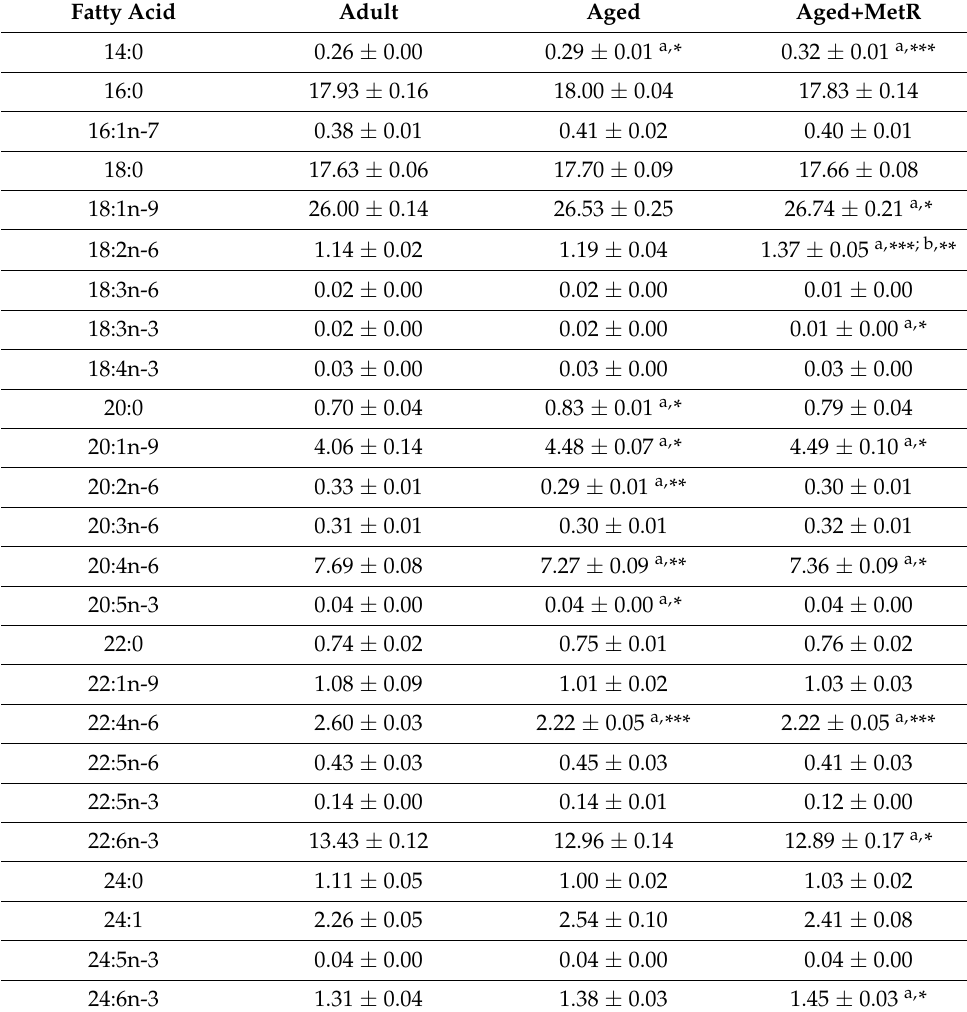
Data are expressed as mean ± SEM. a Comparison between aged and aged+MetR with the adult group; b com- parison between aged and aged+MetR groups. * p < 0.05. ** p < 0.01. *** p < 0.001. n (Adult) = 8, n (Aged) = 8, n (Aged+MetR) =